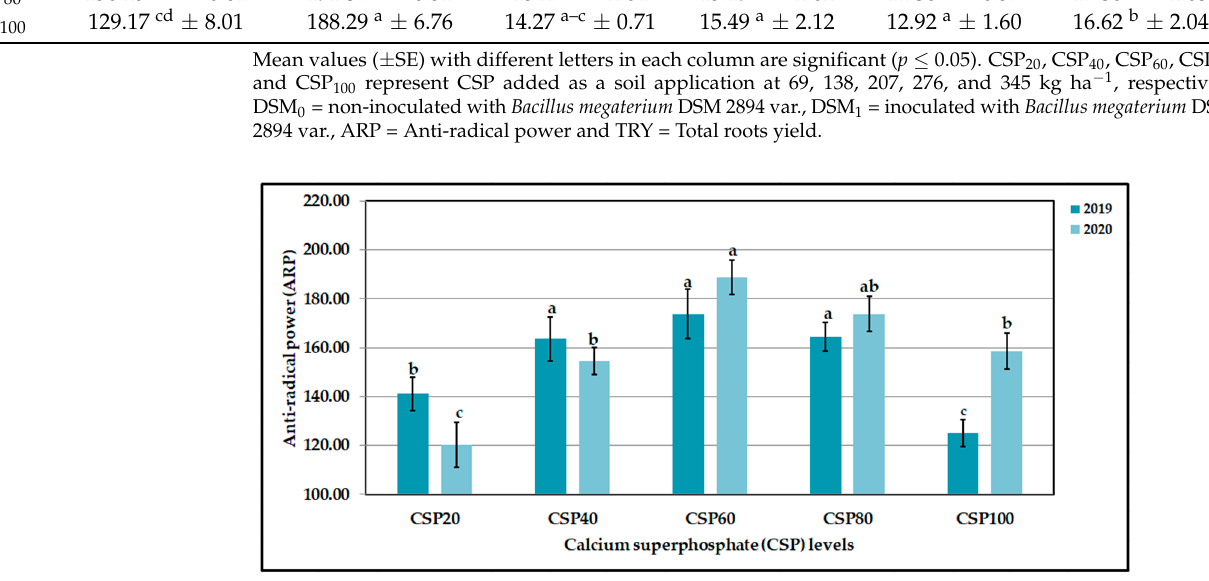
Figure 17. Influence of calcium superphosphate (CSP) levels on anti ‐ radical power (ARP) of tubers of CaCO 3 ‐ stressed sweet potato plants grown in 2019 and 2020 seasons. Bars with a different letter indicate significant different between treatments at p ≤ 0.05. CSP 20 , CSP 40 , CSP 60 , CSP 80 , and CSP 100 represent CSP added as a soil application at 69, 138, 207, 276, and 345 kg ha − 1 , respectively.